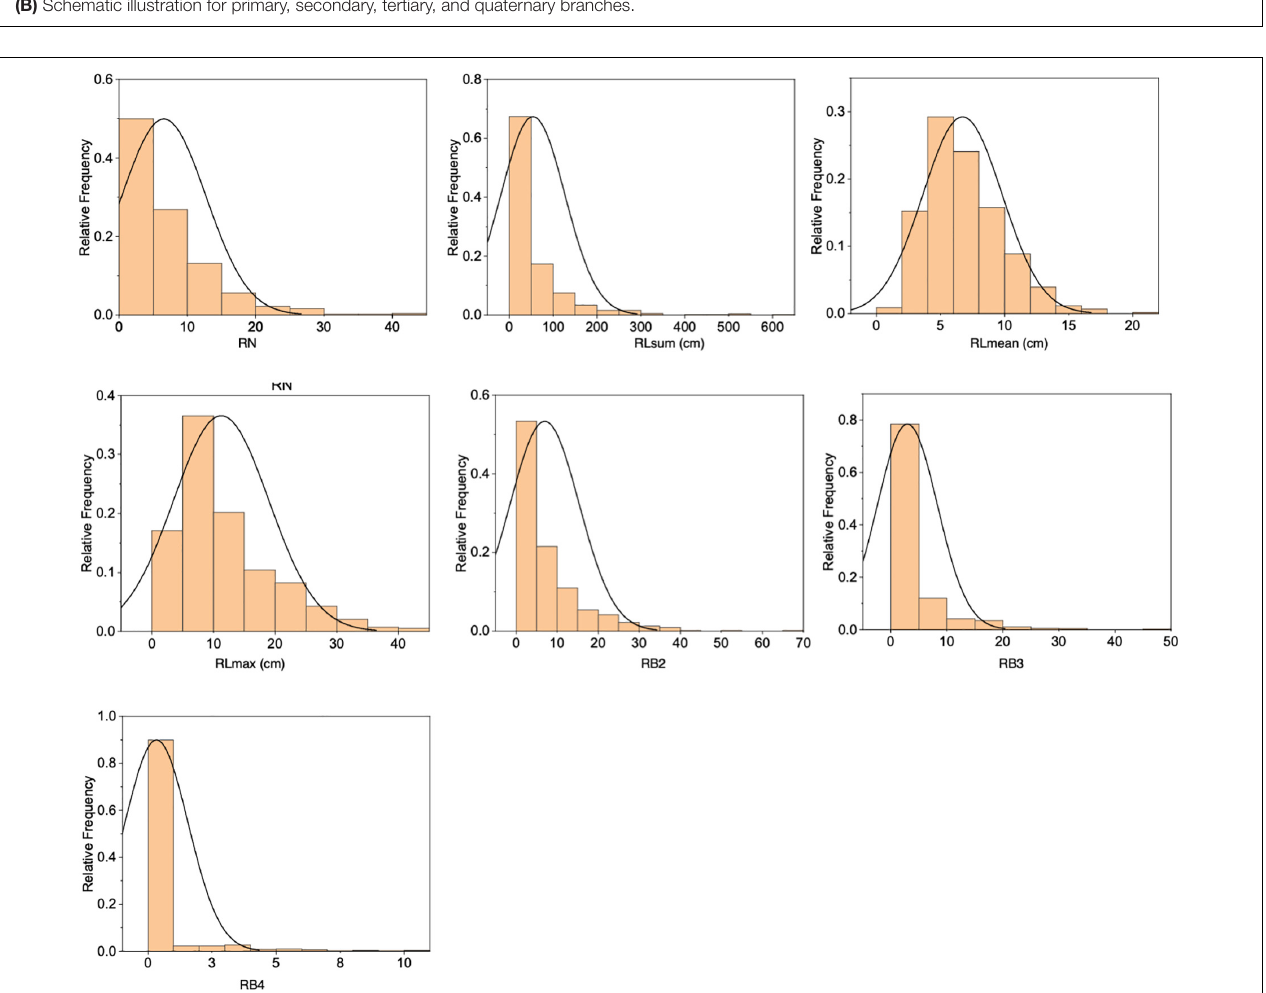
FIGURE 2 | Distributions of seven rhizome-related traits in the F 2